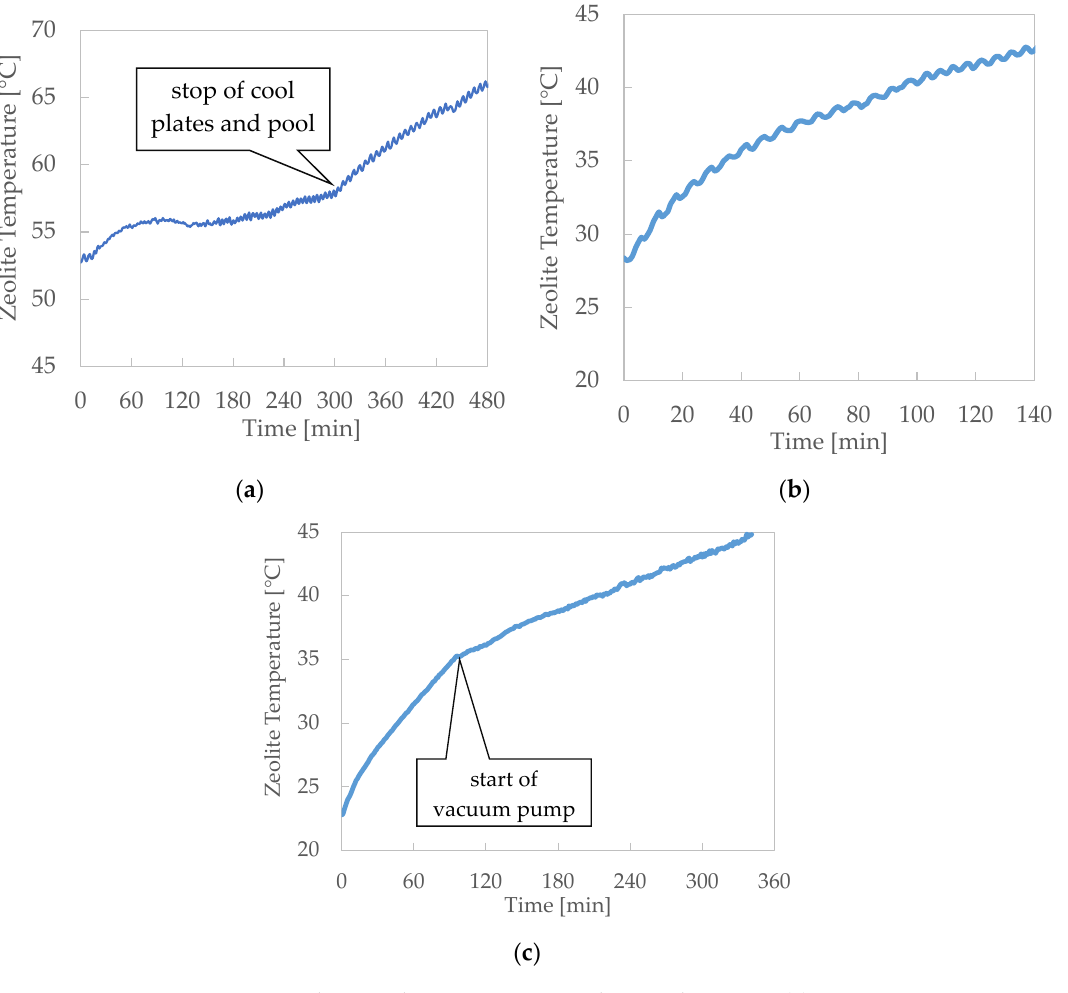
Figure 6. Desorption results: zeolite temperatures during the test. ( a ) Desorption—Test 1, ( b ) Desorption—Test 2 and ( c ) Desorption—Test 3.